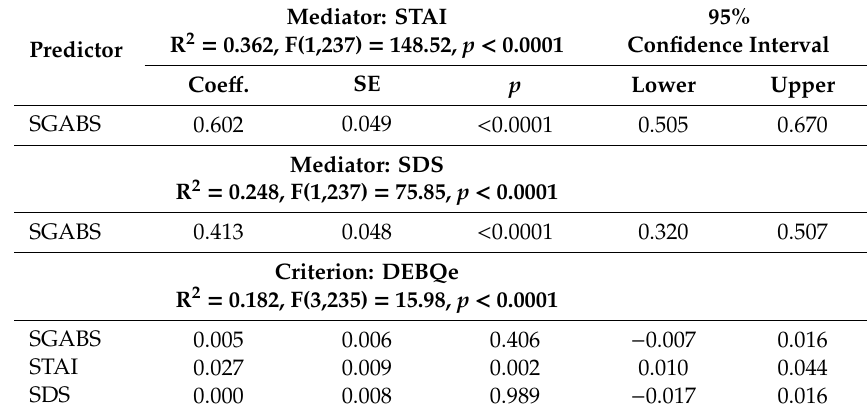
Table 3. Multiple mediation model predicting DEBQe from SGABS. Total e ff ect: R 2 = 0.181, F(3,235) = 15.98, p < 0.0001.